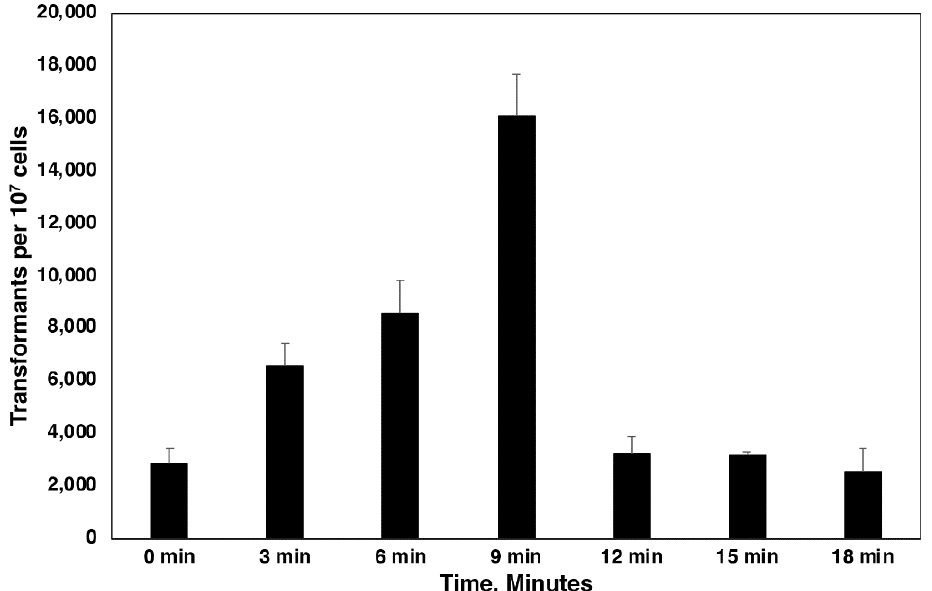
Figure 2. The effect of cell wall damage on transformation frequency. Yeast cells were vortexed with glass beads for the indicated times (X axis). Experiments were performed in triplicate, with three plates per experiment, and counted at 24 h. Colony counts are per 1 × 10 7 C. neoformans cells. The 3, 6, and 9 time points were significantly different from each other and the 0, 12–18 time points, while the 12–18 time points were not significantly different from the 0 time point ( P < 0.05).